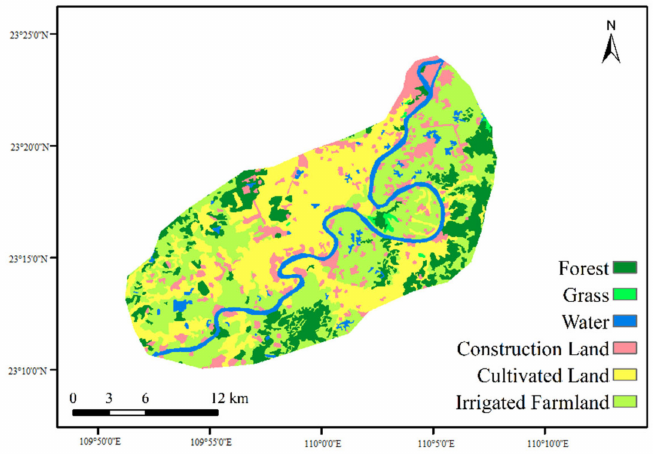
Figure 3. The distribution of land-use types in the cassava planting